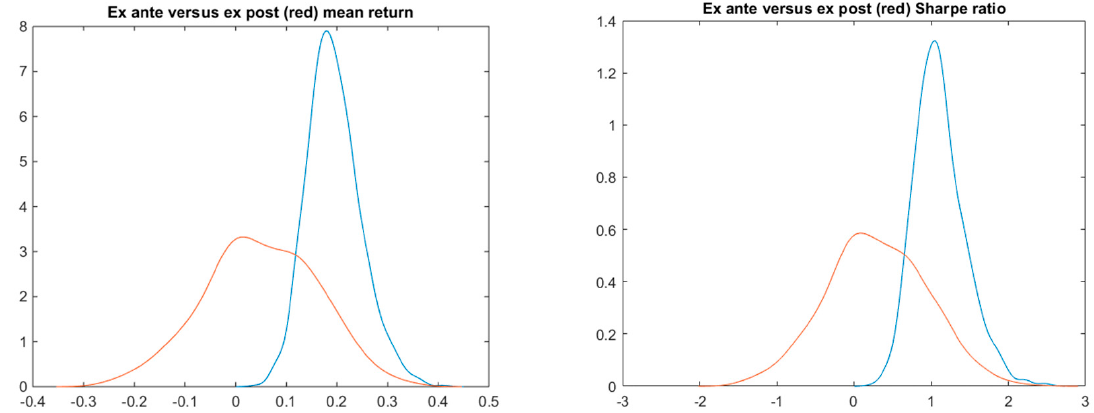
Figure 7. Sharpe ratio’s probability density according to White ´ s reality check.